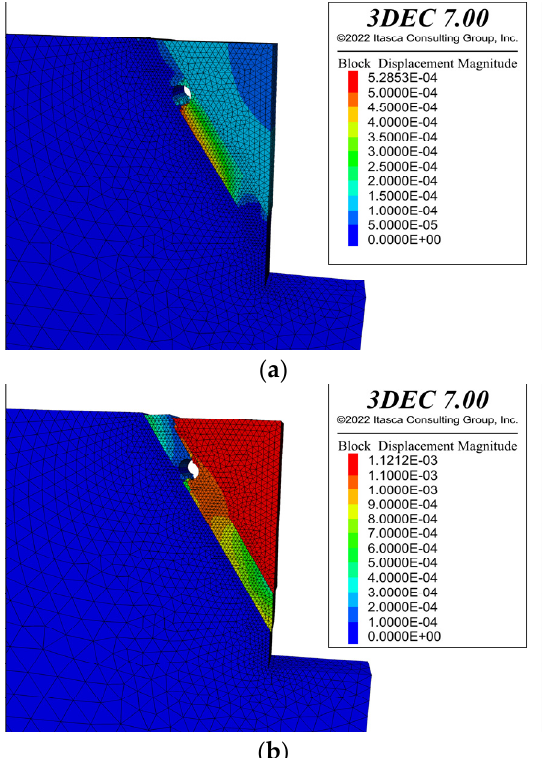
Figure 2. Failure process of a 4 m-wide rock mass with circular karst caves penetrating into the foundation pit at 60° structural plane dip angle. ( a ) 5000 steps; ( b ) 8500 steps.